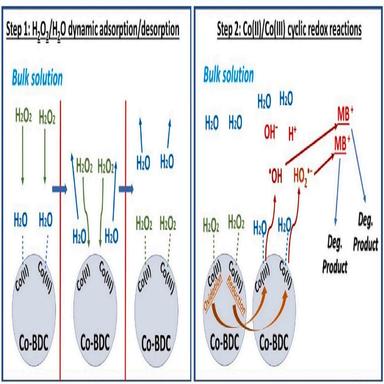
Proposed decomposition mechanisms of H2O2 by Co-BDC (step 1), and catalytic degradation of MB (step 2).